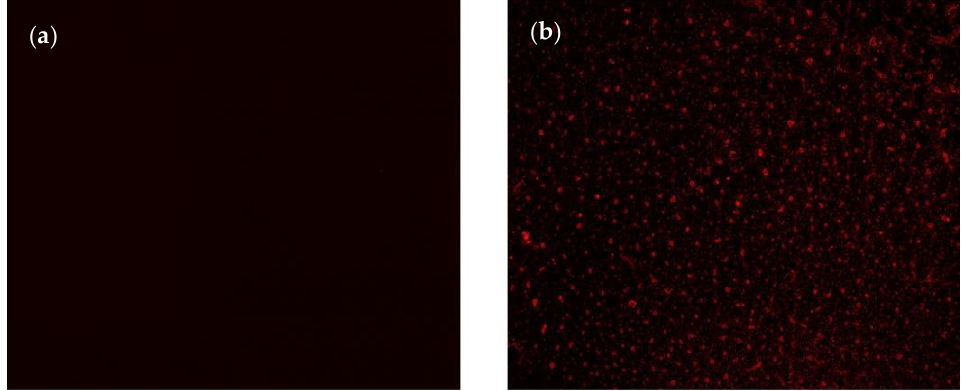
Figure 2. Fluorescent microscopy images of sensing surface ( a ) after MUDA coating and ( b ) nanoMIP immobilization.